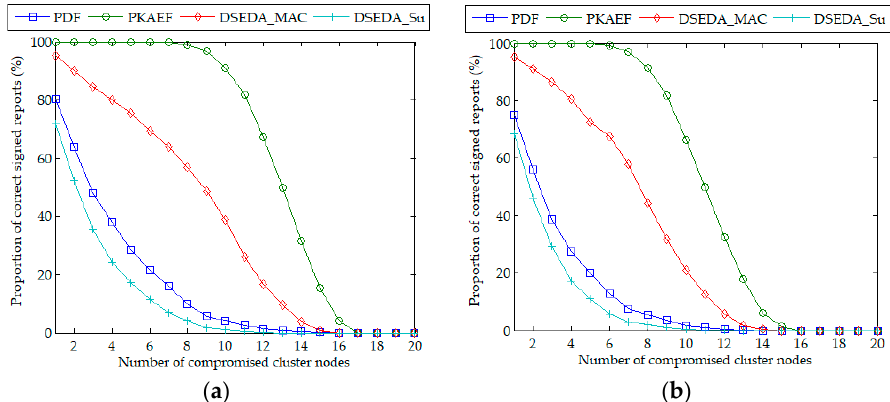
Figure 5. Proportion of correct reports as a function of the number of compromised cluster nodes. ( a ) in Scenario 1; ( b ) in Scenario 2.